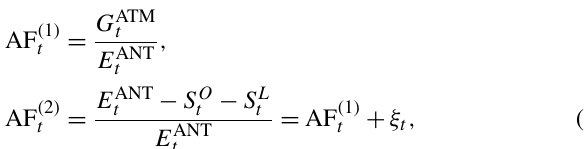
Table 1 also contains diagnostic statistics for the standard- ized prediction residual u t based